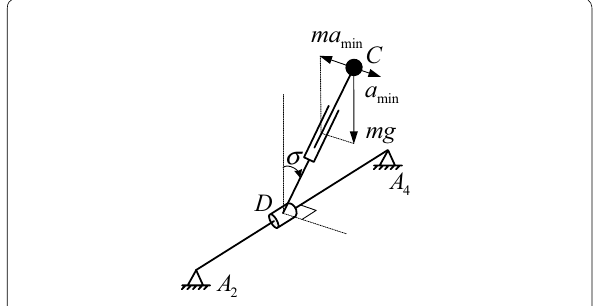
Figure 15 Force diagram of mass point C